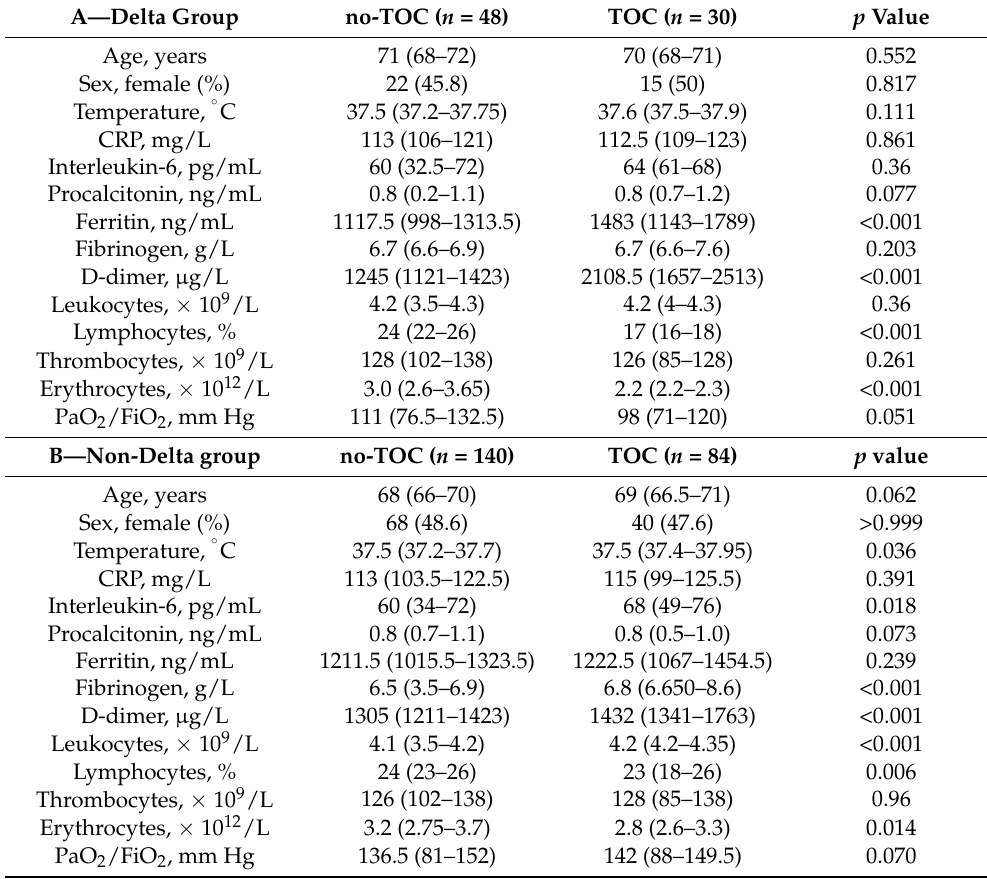
Table 3. Basic demographic and medical data of the study groups with respect to treatment with tocilizumab. Median (Q I –Q III ) for continuous variables, numerical values (%) for categorical variables. The Mann–Whitney test was used for comparison between continuous variables, and Fisher’s exact test was used for categorical variables.